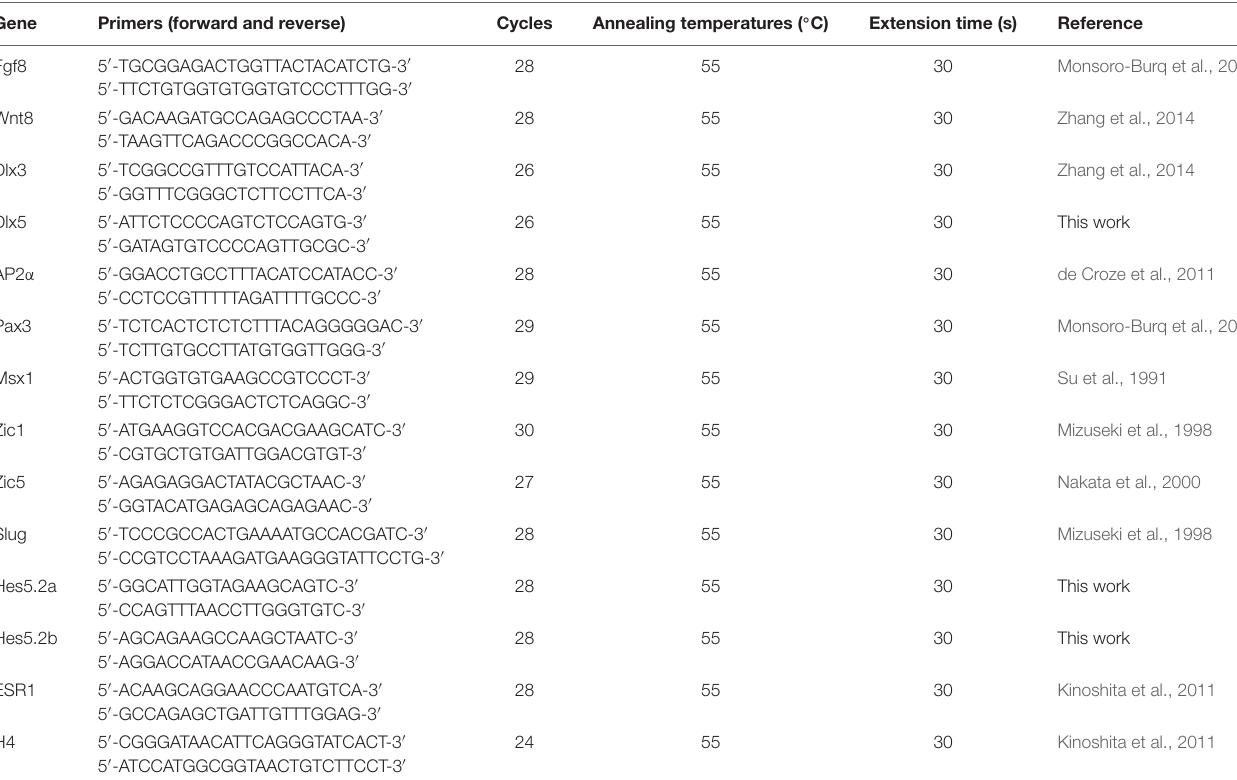
TABLE 1 | RT-PCR primers used in this